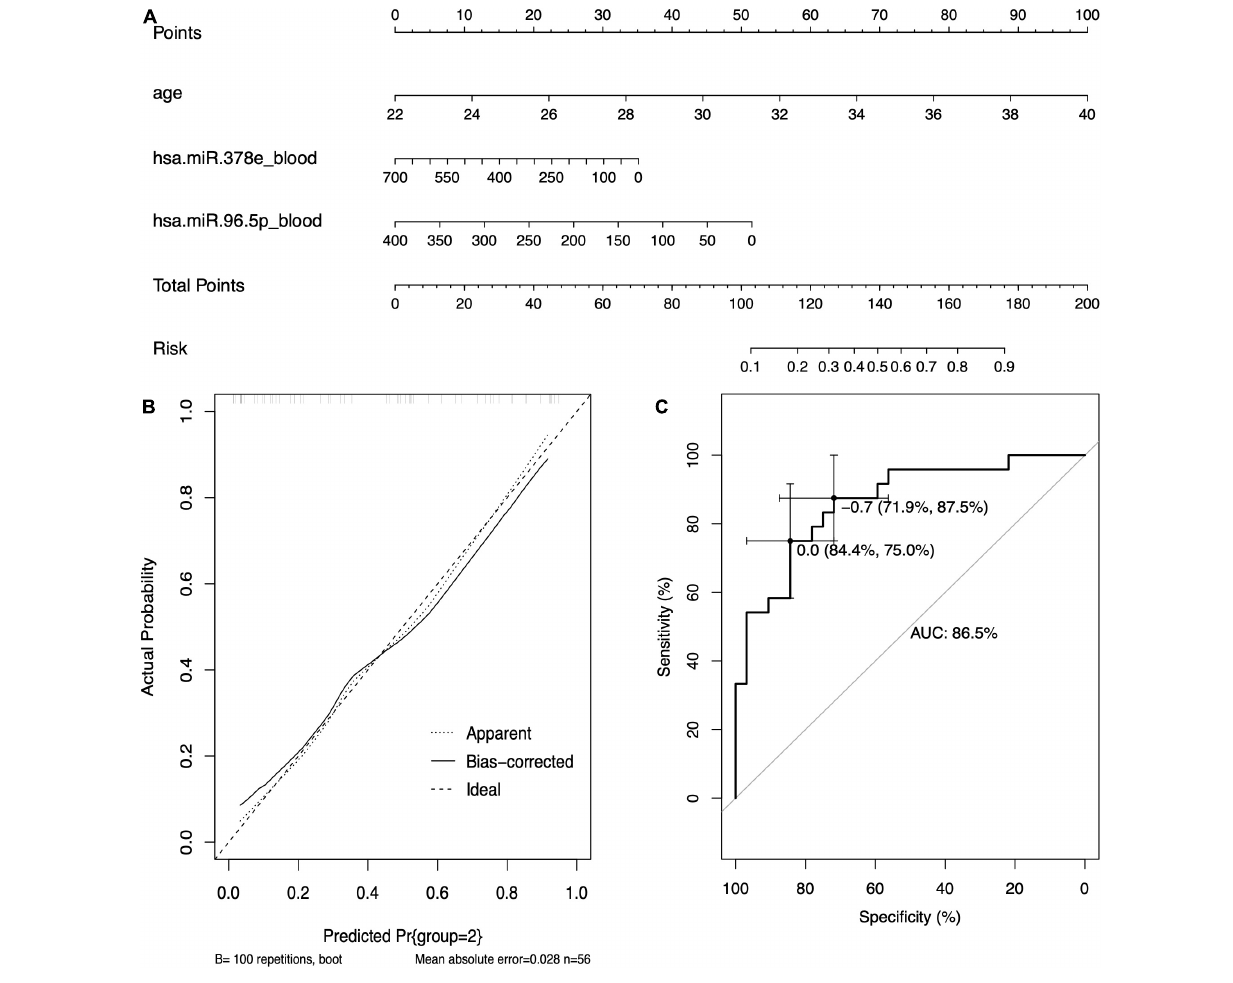
Frontiers in Genetics |